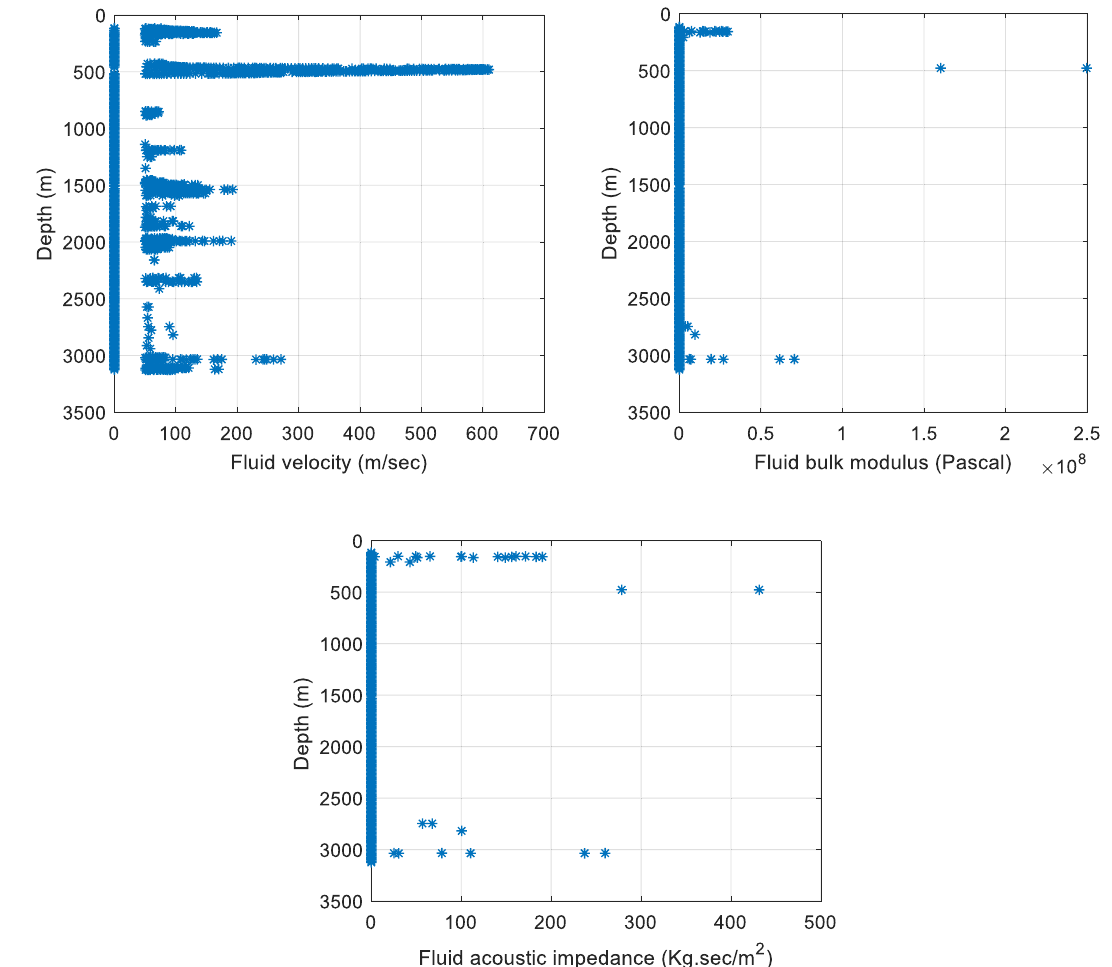
Fig. 12 Fluid velocity, bulk modulus, and acoustic impedance of